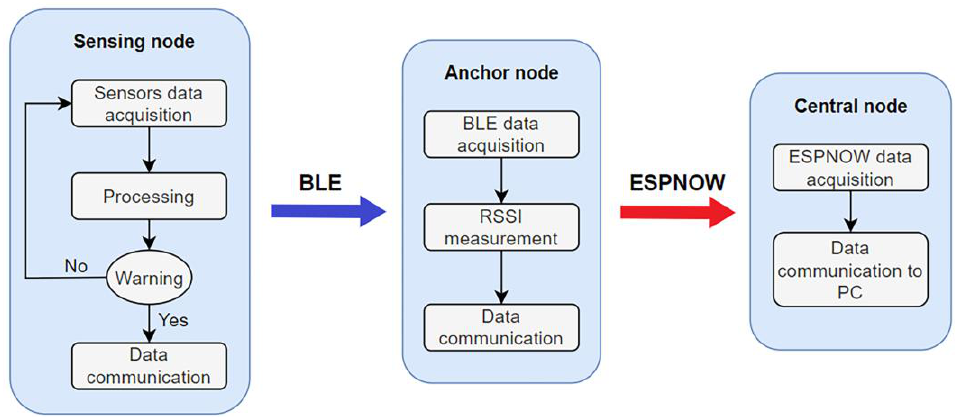
Figure 2. Block diagram of sensing, anchor, and central nodes and their communication path.